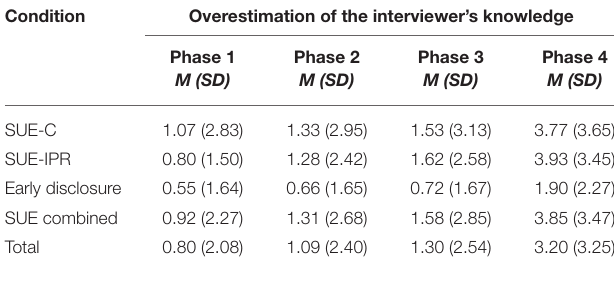
TABLE 2 | Descriptive statistics for the suspects’ overestimations of the interviewer’s knowledge about the critical phase of the crime. Condition